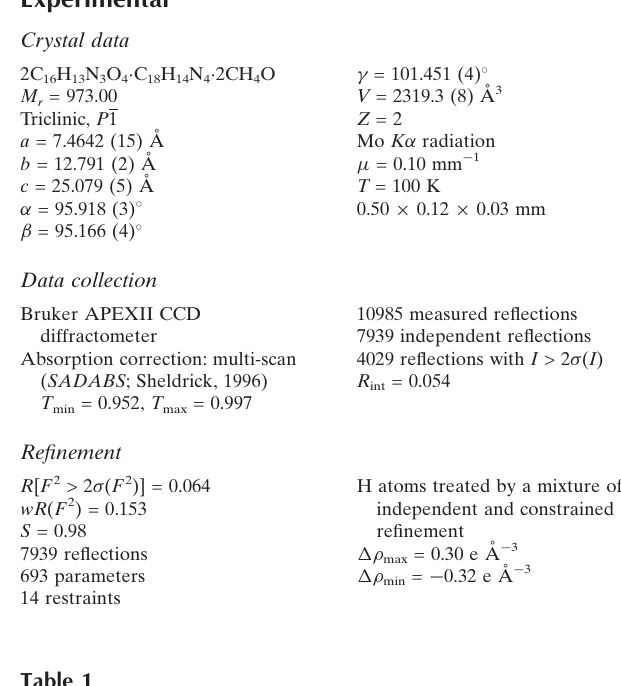
Hydrogen-bond geometry (A˚ , (cid:3) ). D —H (cid:2)(cid:2)(cid:2)